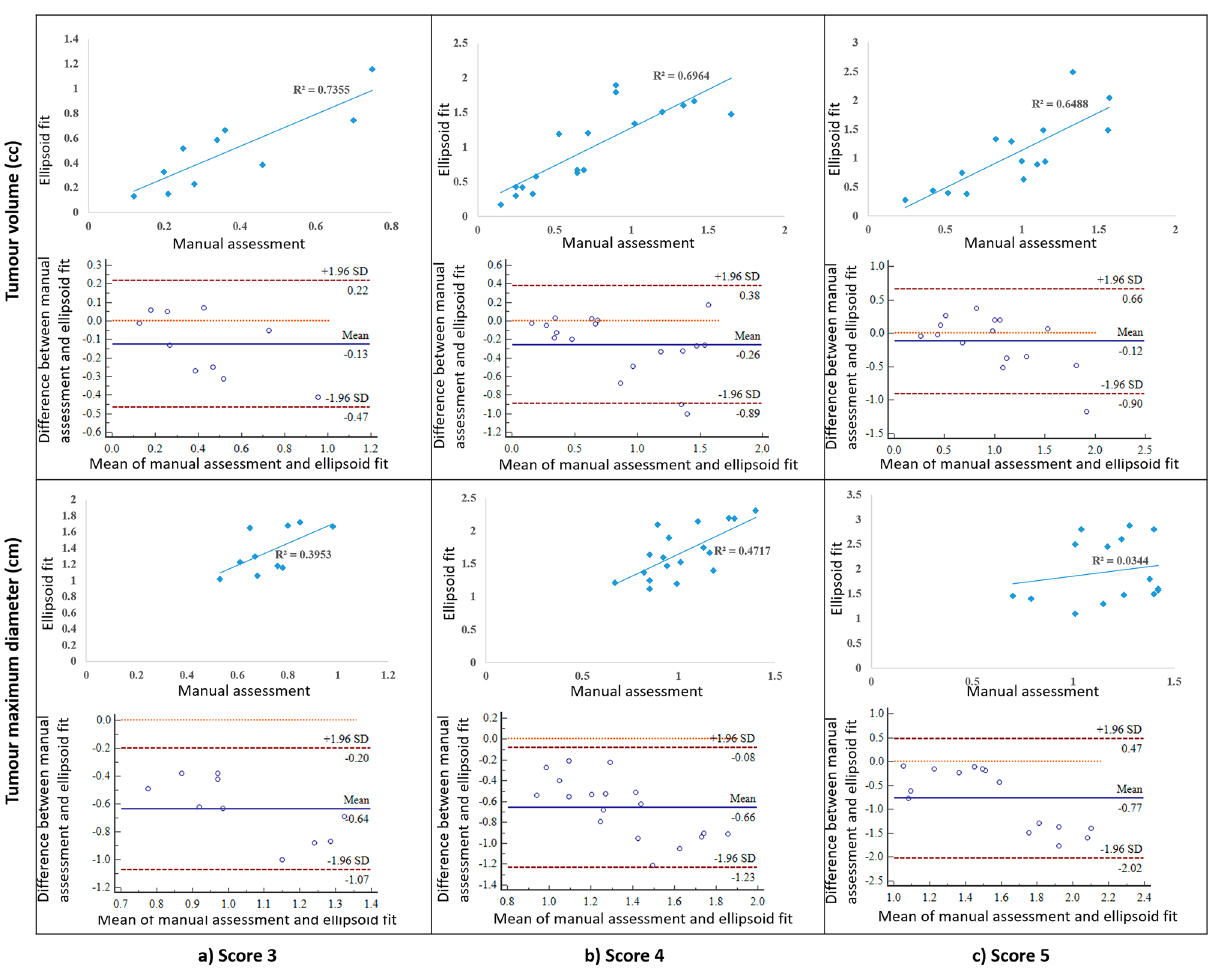
Figure 2. Scatter-plots and Bland–Altman plots for manual assessment and ellipsoid-fit method estimated TV and TMD for ( a ) score 3, ( b ) score 4 and ( c ) score 5. Mean difference is represented by blue solid line and limit of agreement is represented by dotted line. TV Tumour volume, TMD Tumour maximum 1.01 ± 0.19 cm for score-4 and 0.93 ± 0.39 cc and 1.14 ± 0.25 cm for score-5, respectively. The measurements using ellipsoid-fit method were 0.49 ± 0.31 cc and 1.36 ± 0.28 cm for score-3, 0.99 ± 0.58 cc and 1.67 ± 0.38 cm for score-4 and 1.12 ± 0.78 cc and 1.97 ± 0.67 cm for score-5, respectively. Ellipsoid-fit based 3D-measurement showed significantly higher values ( p < 0.05) for both TV and TMD than manual assessment by factor of approxi- mately 1.31 for TV and 1.74 for TMD. There was good correlation ( r = 0.85 and p < 0.05) for TV and moderate correlation ( r = 0.55 and p < 0.05) for TMD between manual and ellipsoid-fit measurement method. A significant bias in the agreement between manual assessment and ellipsoid-fit based tumour measurements, graphically displayed by scatter and the Bland–Altman plots (Fig. 2). It was observed that manual assessment of TV and TMD were lower by a range of 17–46% for all scores compared to ellipsoid-fit based measurements. Figure 3 shows the violin-plots, representing the distribution of TV and TMD across all patients with different PI-RADS v2.1 scores for manual assessment and ellipsoid-fit method. The absolute relative percentage difference between manual-assessment and ellipsoid-fit measurement derived TV and TMD was 26% for score-3, 25% for score-4, 17% for score-5 and 46% for score-3, 34% for score-4 and 42% for score-5, respectively. 3D tumour measurements based PI-RADS v2.1 assessment showed that for score 3, 4 out of 10 patients (40%) were classified as score-5, and for score-4, 11 out of 18 (61%) patients were classified as score-5 compared to manual-assessment. Figure 4 represents the lesion measurement of one representative male patient (age = 60 years) using manual and ellipsoid-fit method, where PI-RADS score changed from 4 to 5. Table 2 presents the TV and TMD for all 15 patients where PI-RADS score was found to be changed among the two methods; it clearly shows the increase in PI-RADS score from 3 to 5 in 4 patients and from 4 to 5 in 11 patients in the cohort (Table 2).